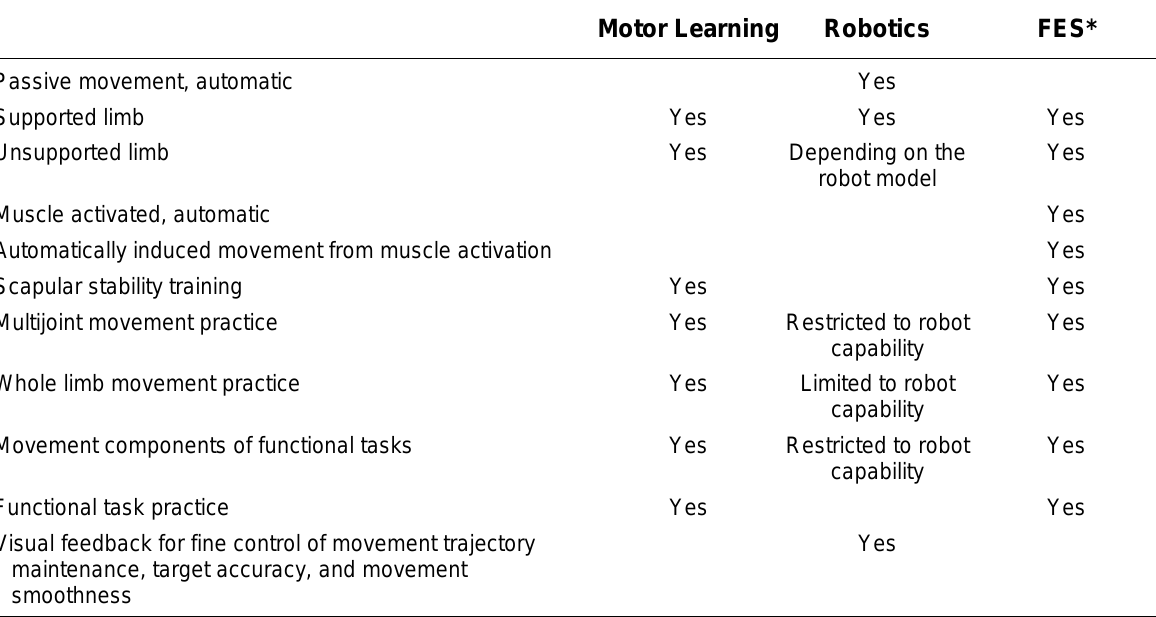
Practice Advantages of Motor Learning, Robotics, and FES Motor